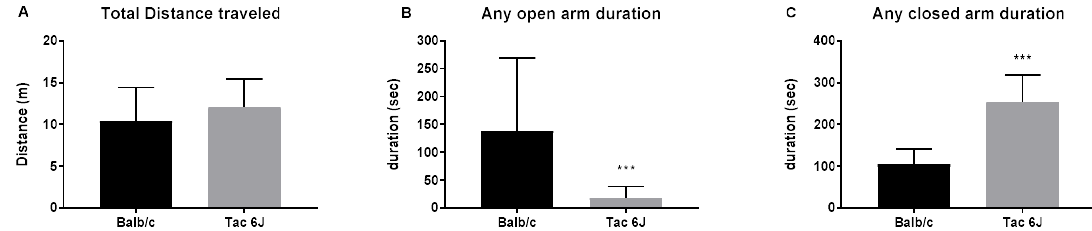
Figure 3. Distances traveled on the elevated plus maze and time spent in the open and closed arms. Using the elevated plus maze test, the initial anxiety of BALB/cAnNTac (Balb/c) mice and C57BL/6JBomTac (Tac 6J) male mice was measured. Each group comprised 9–14 animals. ( A ) Total distance traveled on the elevated plus maze; ( B ) Time spent on any of the open arms; ( C ) Time spent on any of the closed arms. Data are presented as the means ± SD analyzed by Fisher’s LSD test. Significance is indicated when * p < 0.05, ** p < 0.01, and *** p < 0.001.